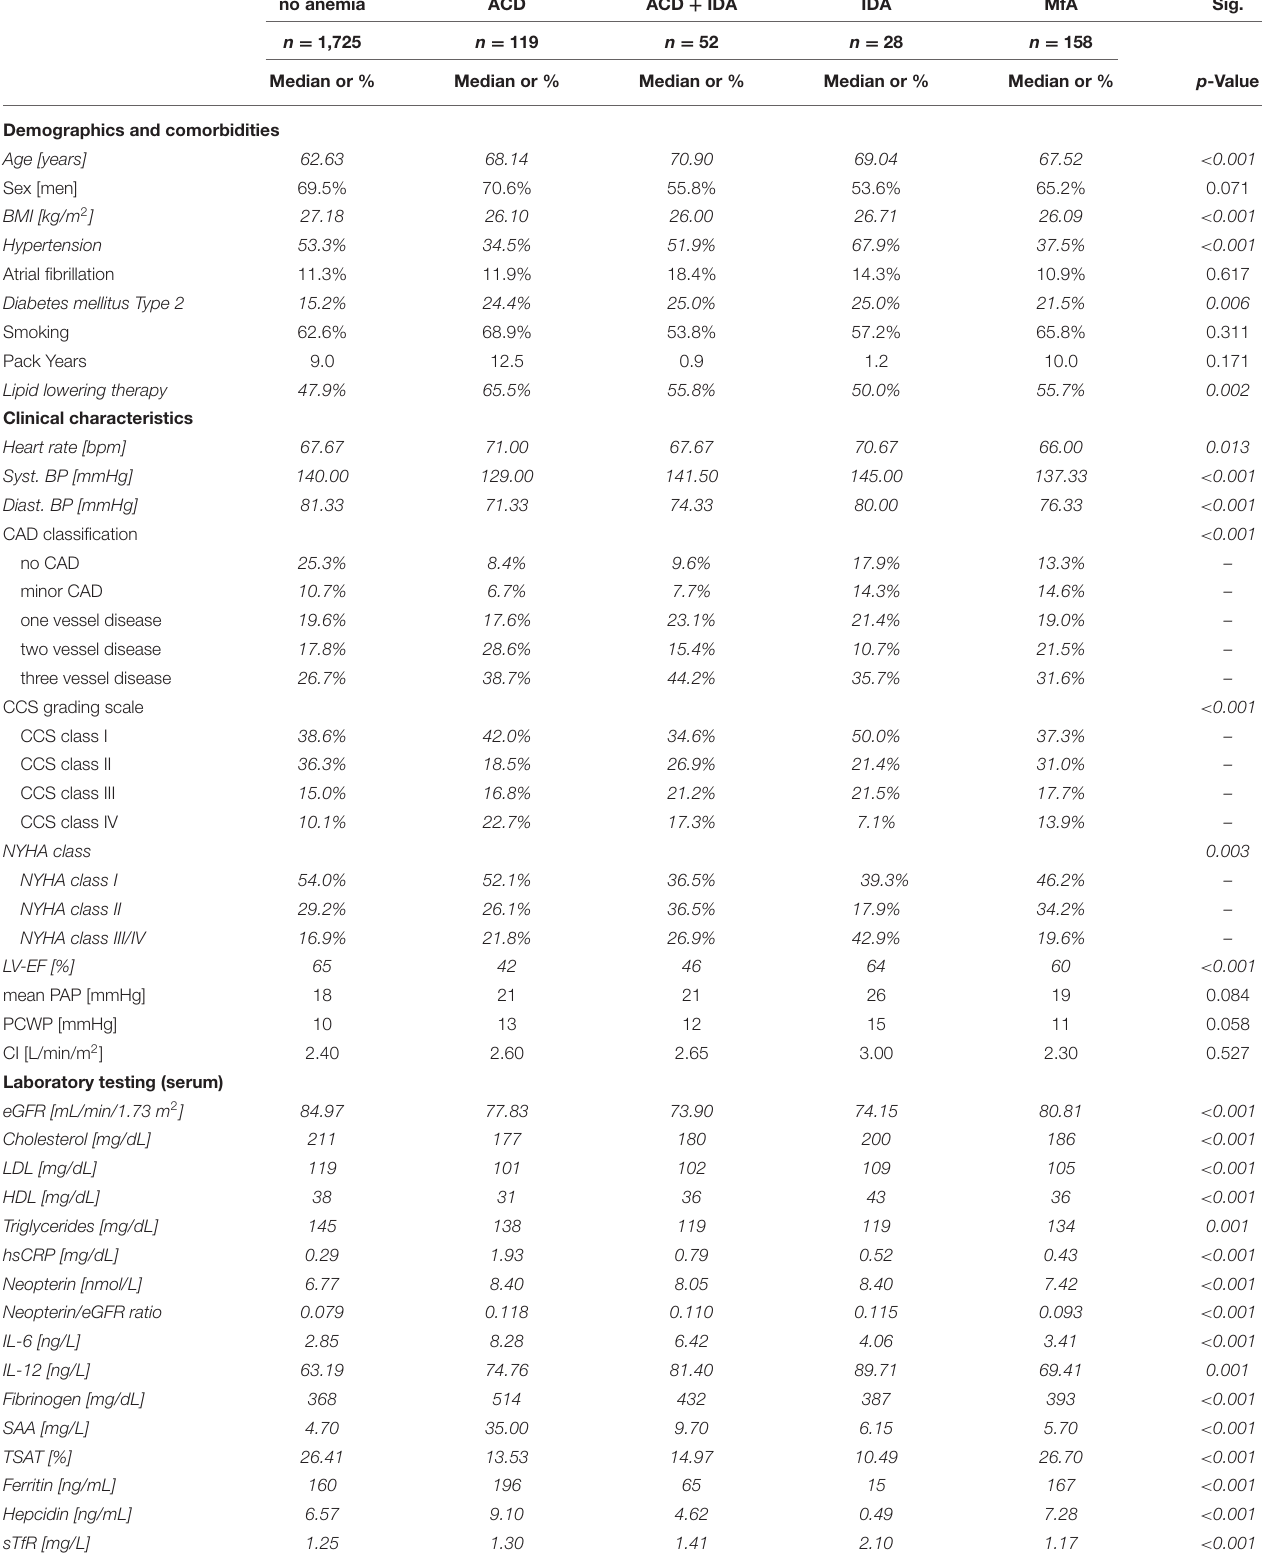
TABLE 3 | Baseline characteristics within the ACD/IDA